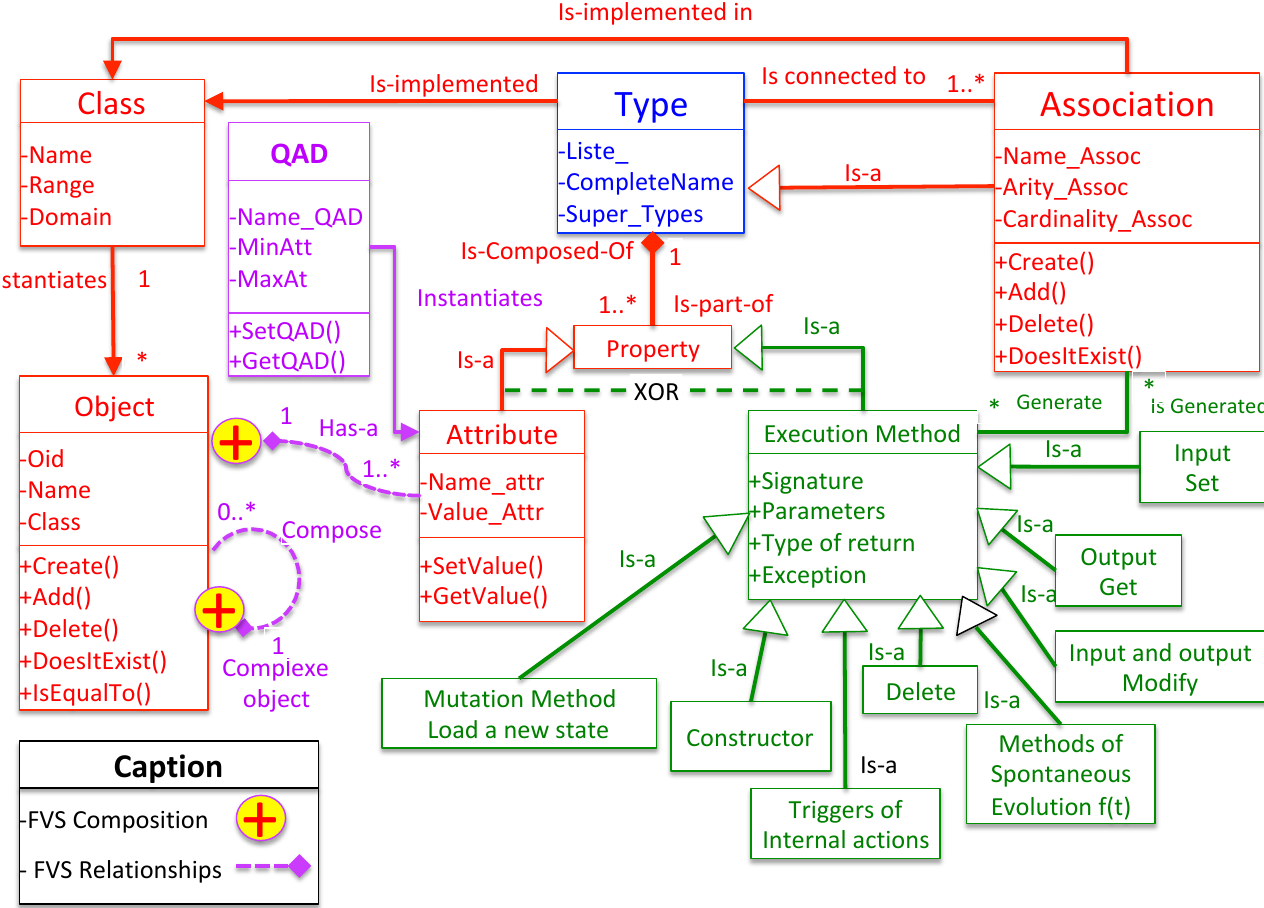
Figure 4. FVSOOMM meta-model describes the object-oriented model extended by TFVS. - Step 3 of Figure 3 concerns the knowledge design with a fuzzy vector space. It relies on the composition relationship and the qualifier attribute descriptors (QADs)